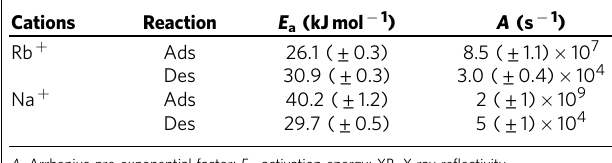
A , Arrhenius pre-exponential factor; E a , activation energy; XR, X-ray reflectivity. Reaction: adsorption and desorption. The numbers in the parentheses are one s.d. uncertainties of the